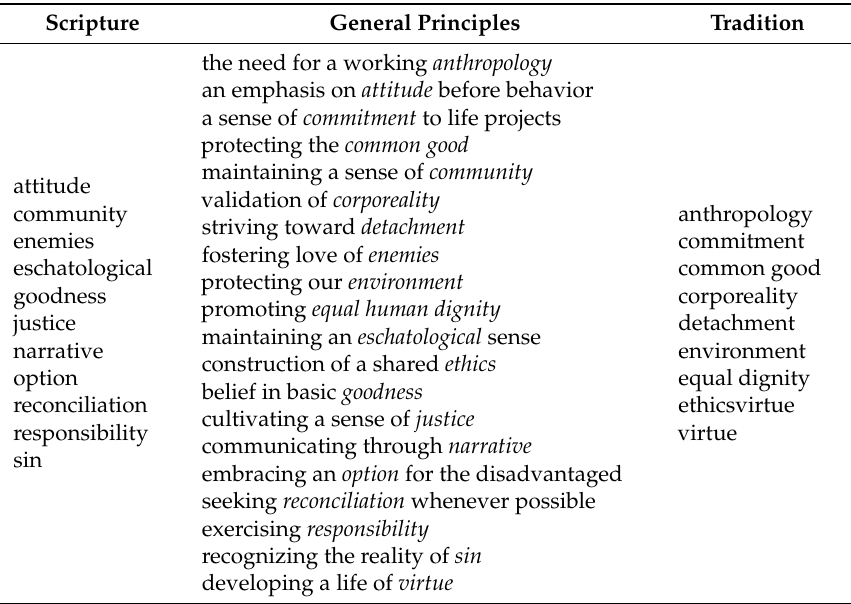
Table 1. General principles of Catholic Christian